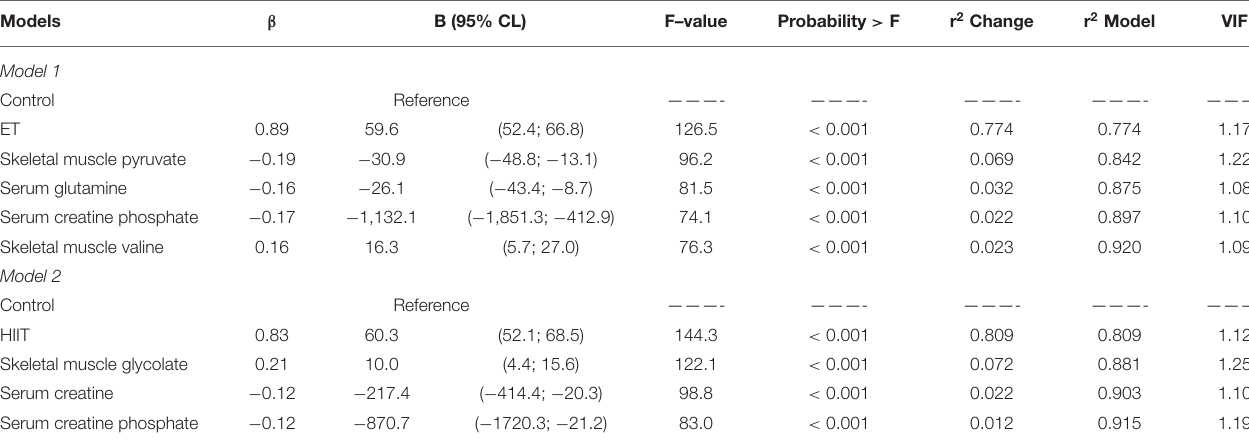
TABLE 6 | Results of the multivariate linear regression model with stepwise selection for the MPO gains in response to training in the TIMES Study.